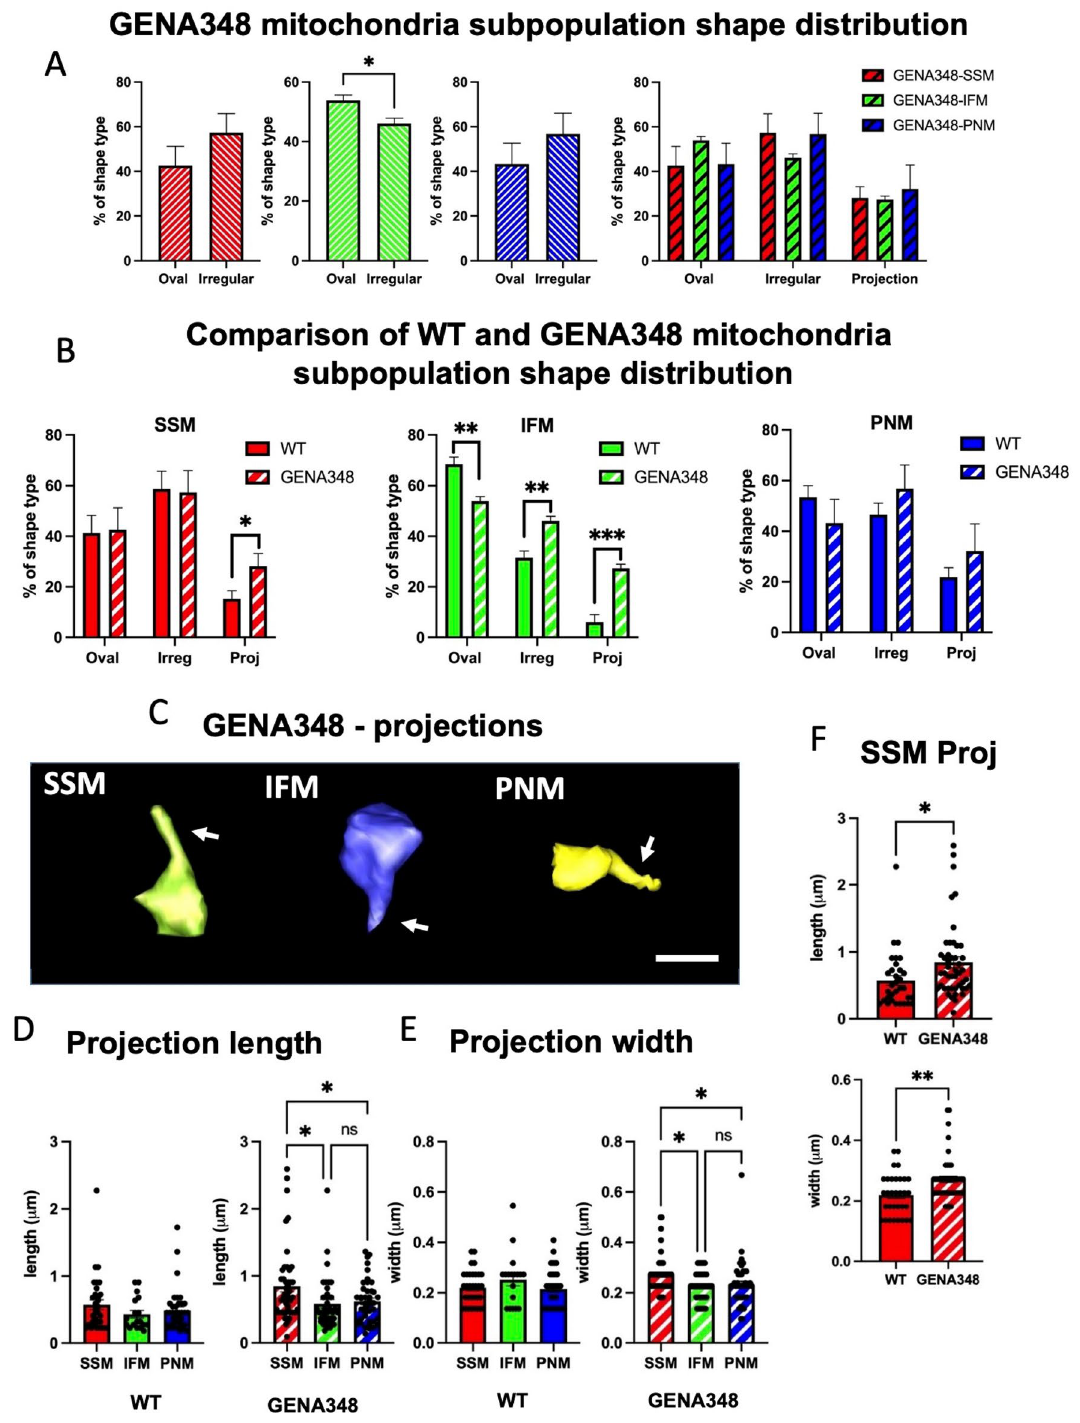
Figure 2. A comparison of the WT SSM, IFM and PNM shape types within GENA348 mitochondrial subpopulations. ( A ) Distribution of the shape type within the GENA348 mitochondrial population. ( B ) A comparison of the WT and GENA348 shape types reveals that GENA348 SSM and IFM have more mitochondria with tubular projections compared to the WT and that there are more irregularly shaped IFM. ( C ) Examples of 3D reconstructions of GENA348 mitochondria with tubular projections. Scale bar = 1 µm. ( D ) Tubular projections from WT mitochondria are the same length independent of mitochondrial subtype whereas GENA348 SSM have longer projections compared to IFM and PNM. ( E ) The width of the WT tubular projections are the same across each mitochondrial group whereas in the GENA348 SSM are wider than the IFM and PNM (raw data points show to spread of measurements, n = 3). ( F ) A comparison of the projection parameters (raw data points shown, n = 3) identified the GENA348 SSM as being longer and wider than WT SSM. There was no difference in IFM and PNM dimensions between the WT and GENA348 (not shown). Projection dimensions are reported in Table